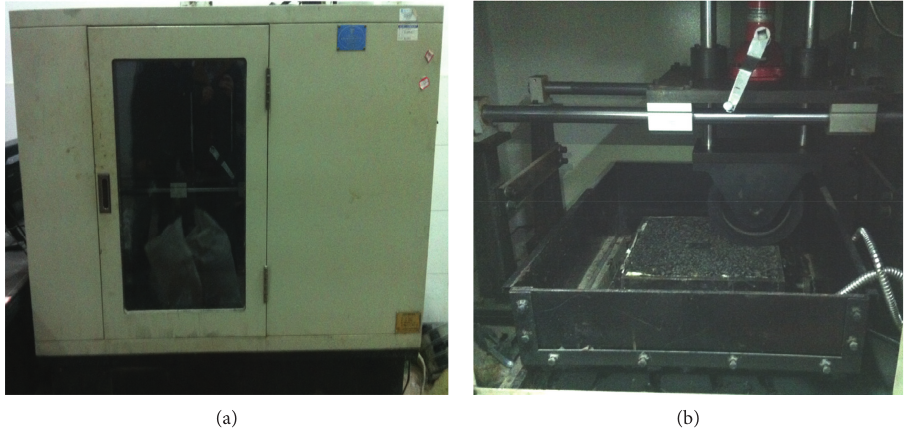
Figure 4: Rutting apparatuses for three asphalt mixtures.